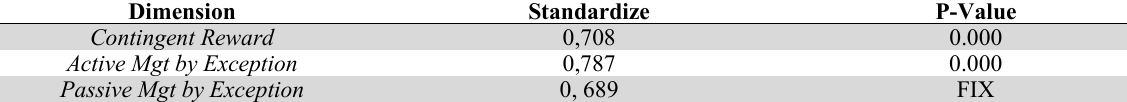
Results of Transactional Leadership Measurement Model Examination (X)